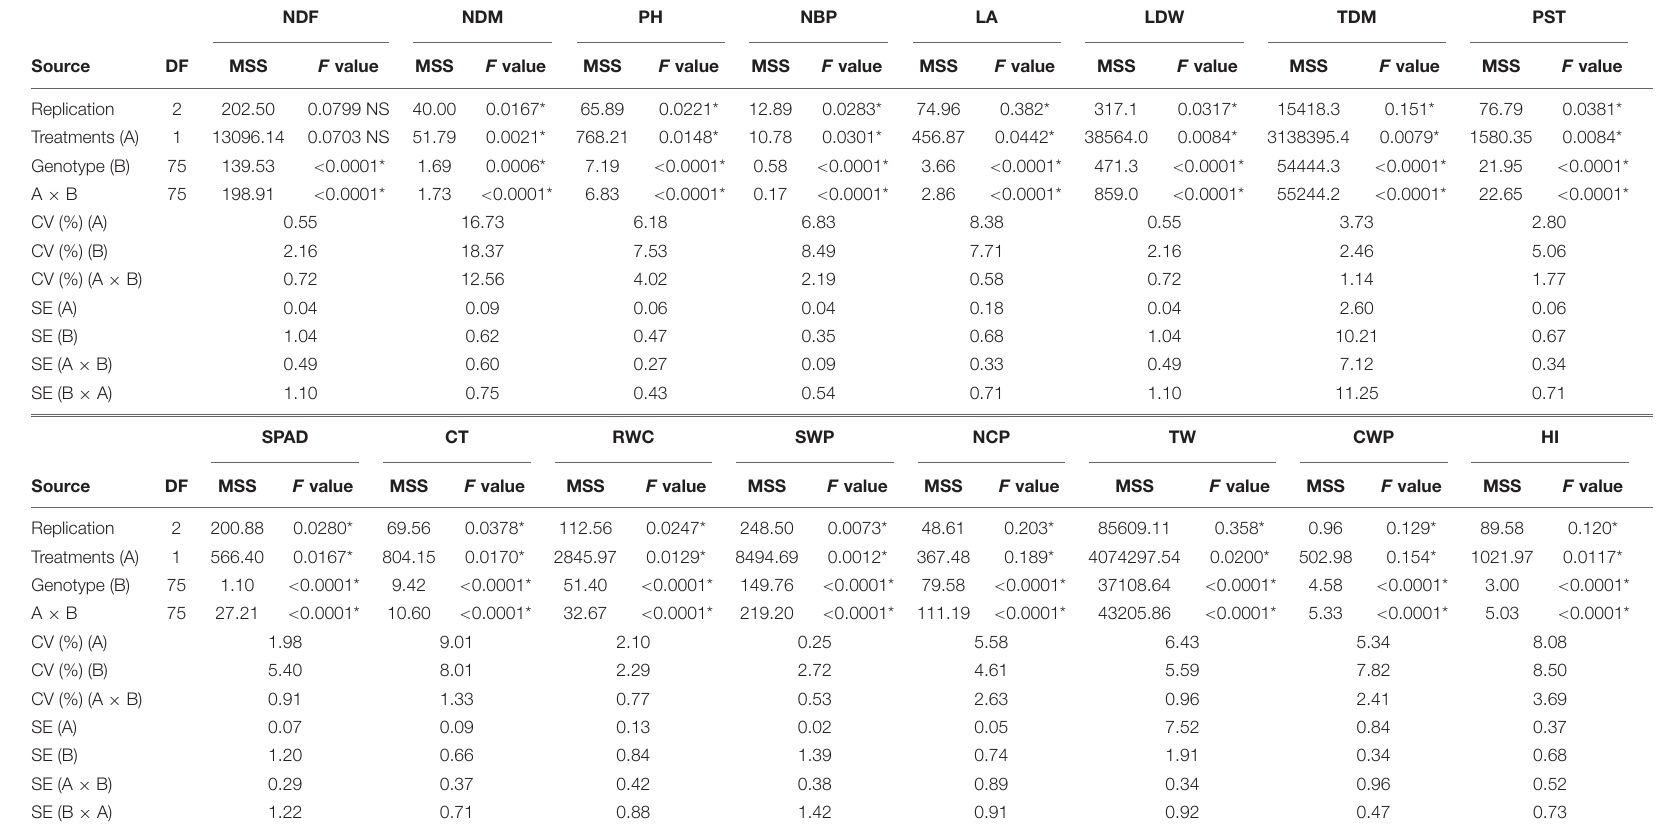
TABLE 2 | Analysis of variance (ANOVA) of 76 sesame genotypes along with checks during the year